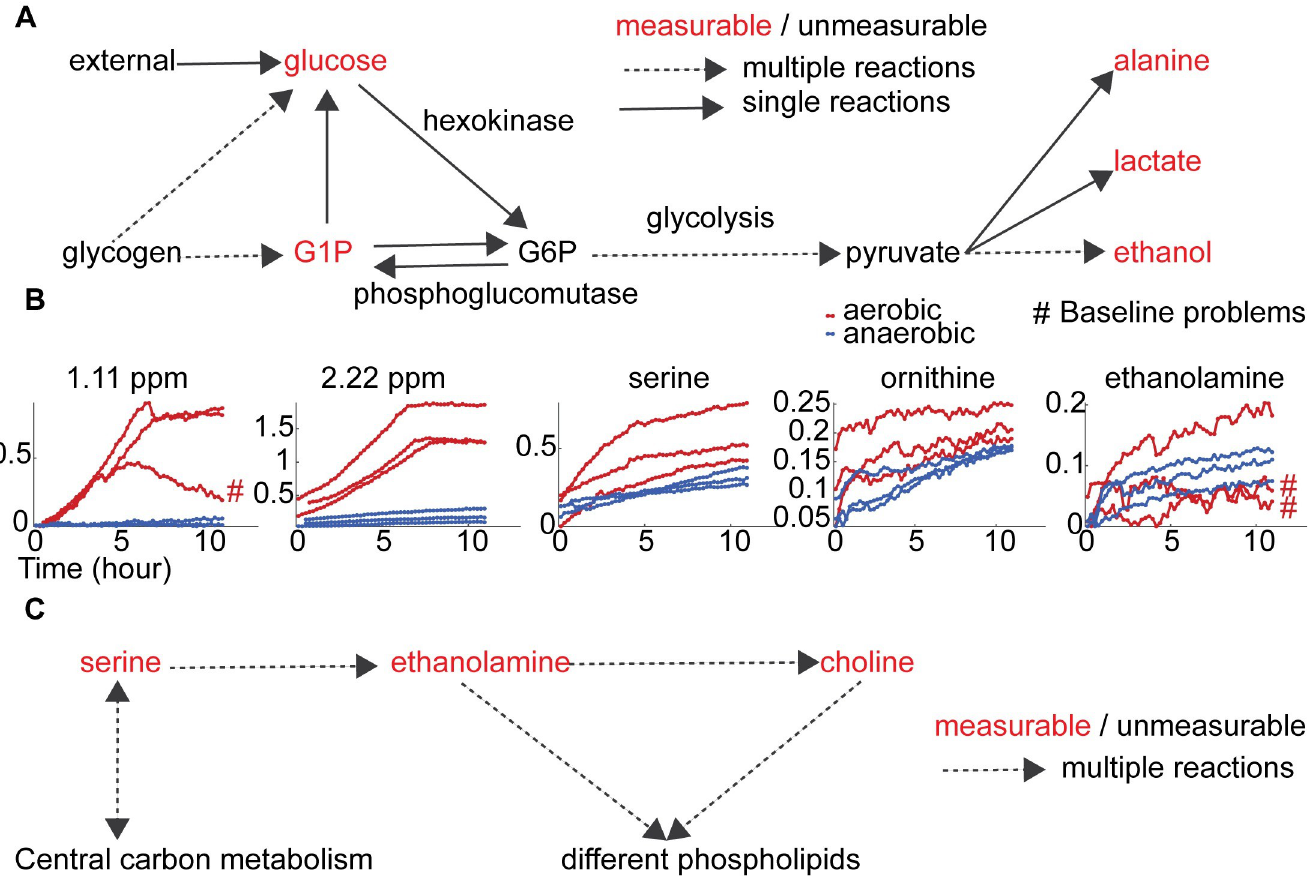
Fig 6. Biochemical connections for central energy metabolism and membrane synthesis in the glucose feeding experiments. A: Hypothesized pathway through the central energy metabolism: glycolysis, glycogen degradation and fermentation. Measured (unmeasured) compounds are visualized in red (black). Steps with multiple (single) reactions are represented by dotted (solid) lines. B: Time-series quantification for selected features: high degree unannotated features in Fig 5B and compounds related to phospholipid synthesis and amino acid metabolism. The X (Y) axis represents time (means of scaled ridge intensities). Red (blue) represents aerobic (anaerobic) conditions. The ‘#’ symbol indicates that the quantified peaks are highly affected by regional baseline changes. C: The hypothesized pathway for phospholipids synthesis.